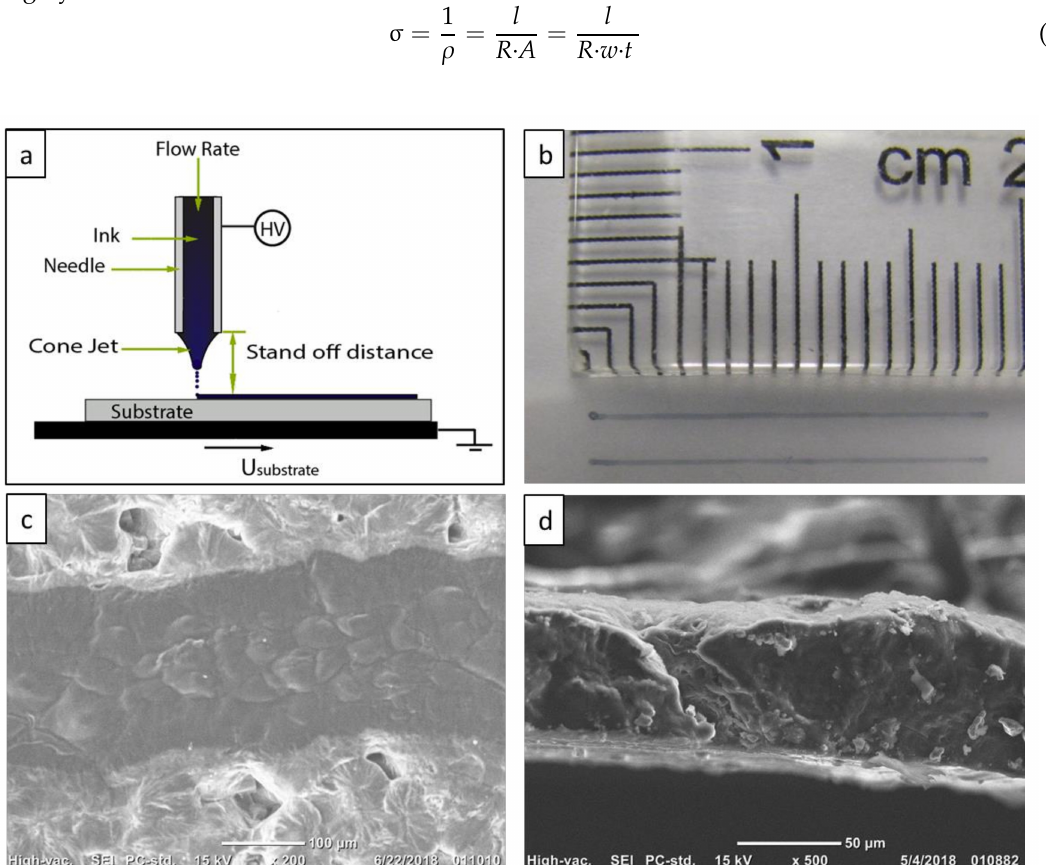
Figure 1. ( a ) Schematic of electrohydrodynamic jet (E-Jet) printer; ( b ) image of the all-polymer electrodes taken with a charge coupled device (CCD) camera; ( c ) electrode image taken with SEM; ( d ) image of cross-section area of electrode taken with